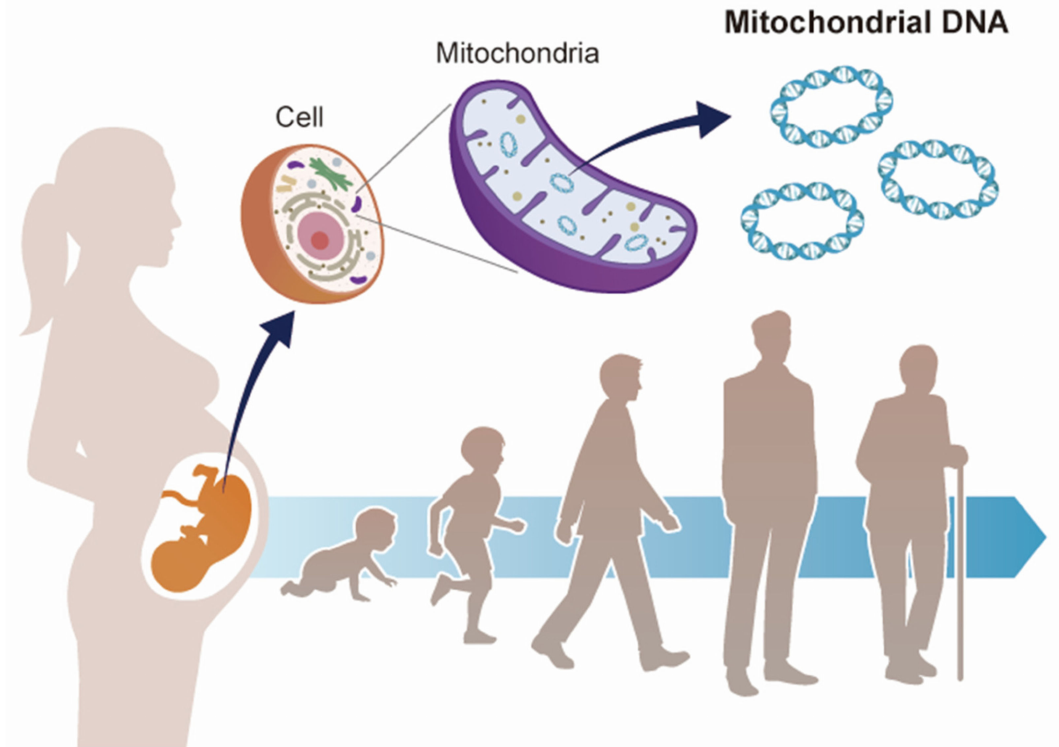
Figure 1. Mitochondrial DNA and developmental origins of health and disease (DOHaD). Mitochondrial DNA copy number increases or decreases in response to environmental changes. Environmental stress during fetal life may contribute to the risk of disease in adulthood via mitochondrial DNA copy